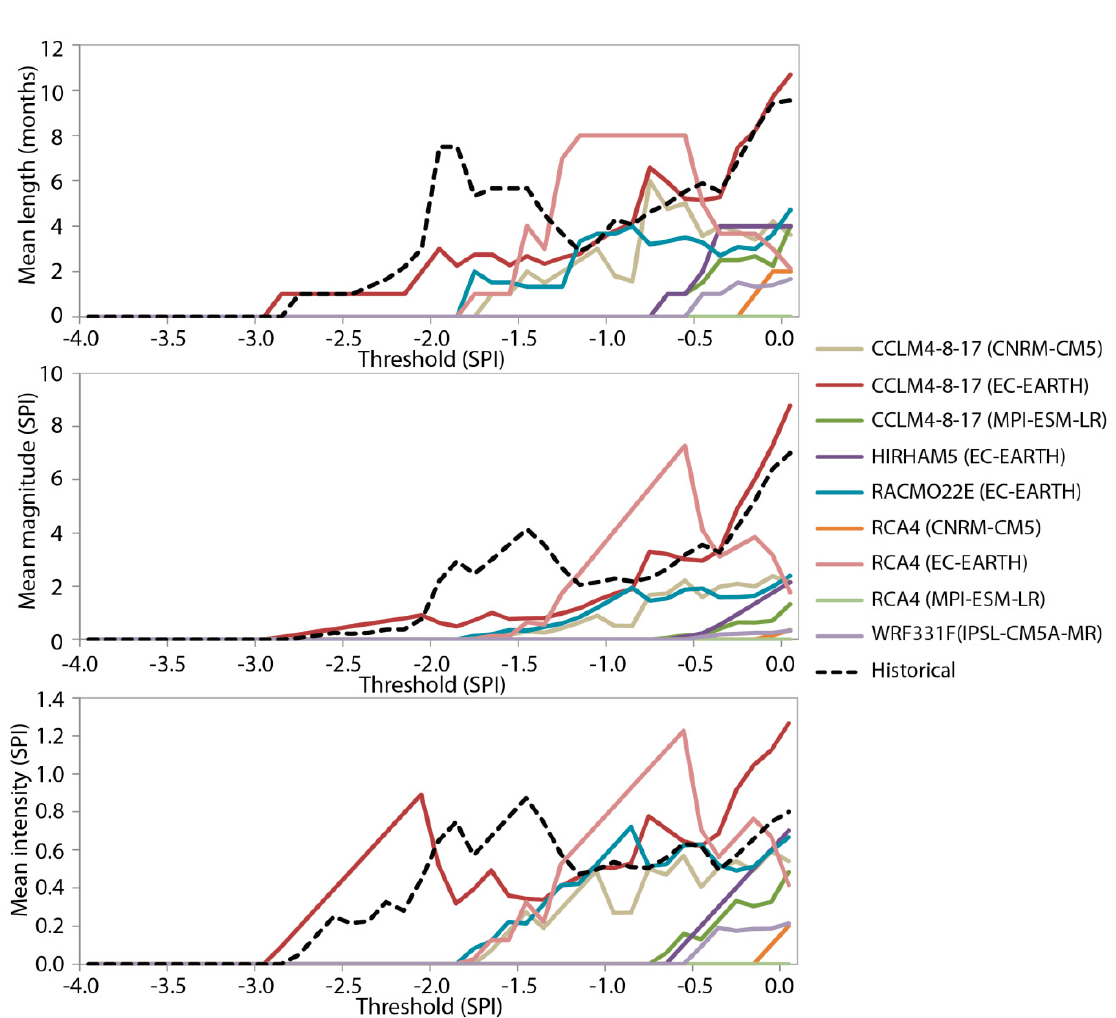
Figure 5. Drought statistics for the historical and control series in the period 1971–2000—lumped approaches.